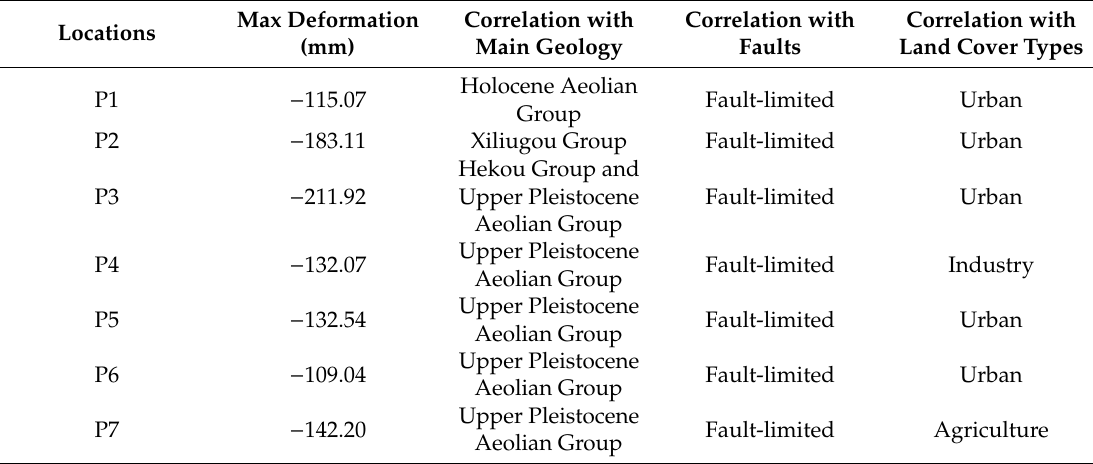
Table 3. Summary of the observations in the seven studied areas: locations, maximum deformation rate, correlation between velocity gradients and locations of pre-existing geological faults, relationship to land cover types (agricultural, industrial and